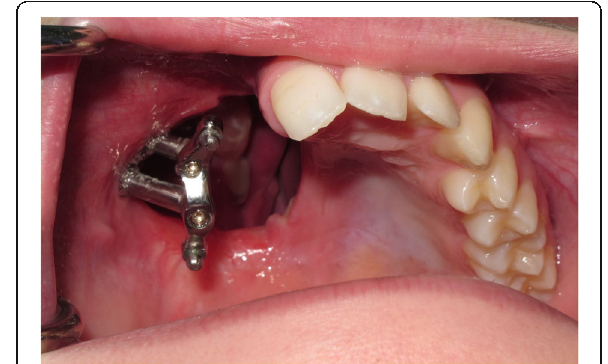
Fig. 4 Twelve-week review post-surgery prior to definitive impressions for the implant-supported prosthesis Fig. 5 Zygomatic implant bar utilising Rhein attachments for